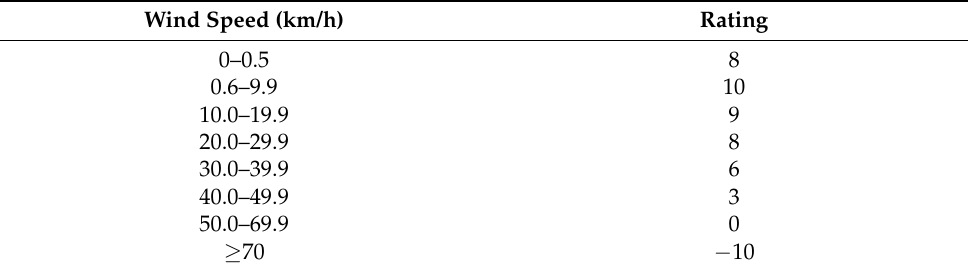
Table A6. Physical facet rating values (wind speed).